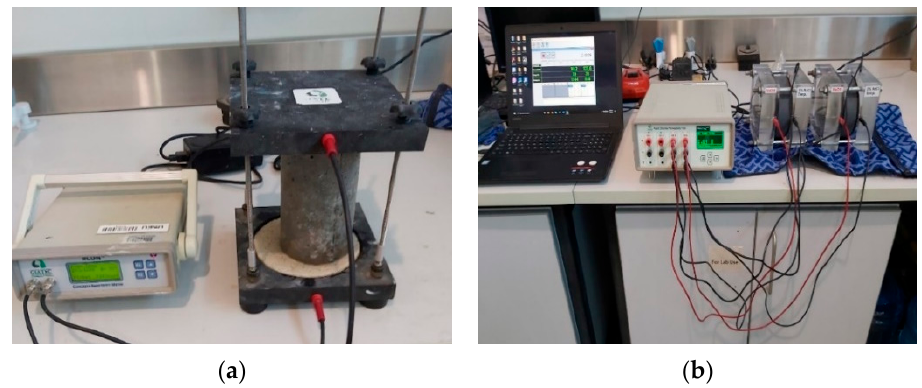
Figure 5. Typical durability tests in progress: ( a ) bulk resistivity; ( b ) RCPT.